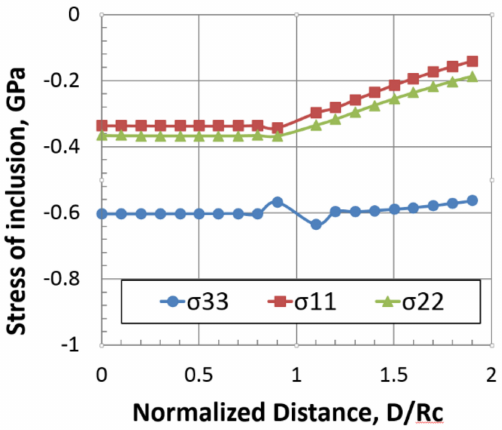
Figure 1. Line profile of inclusion stress along plate normal direction. Uniaxial positive misfit strain normal to the plate is assumed. Center of the inclusion is indicated by D/ R c = 0.0, interface of precipitate and matrix by D/ R c =